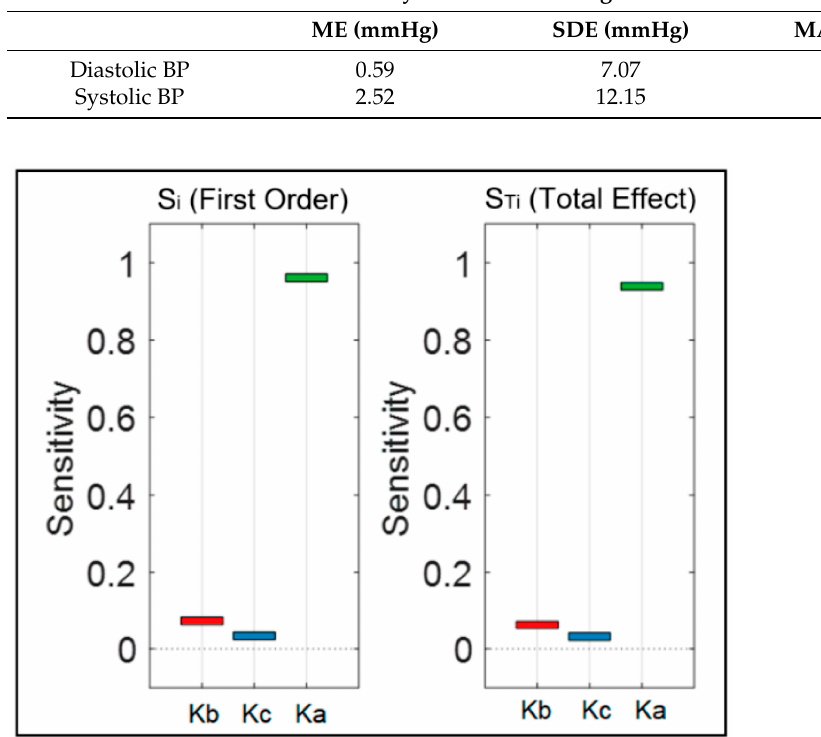
Figure 7. Sensitivity ranking for the DBP model. S i and S Ti show the results for first order sensitivity and total effect sensitivity, respectively. Red, blue and green bars correspond to K b , K c and K a parameters respectively.